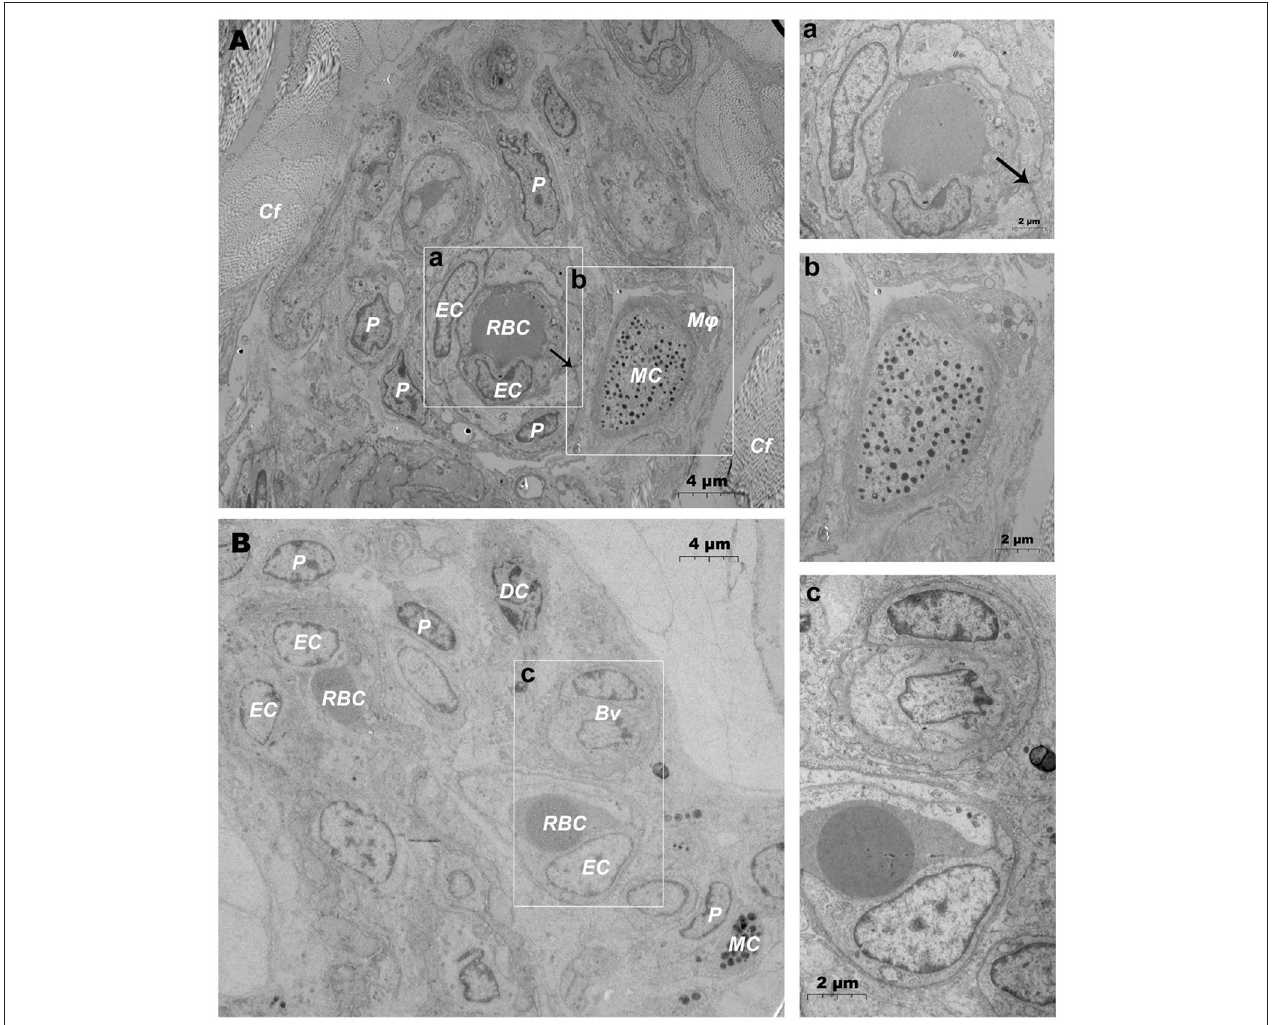
FIGURE 3 | Ultrastructural analysis of microvessels at the steady state via TEM. (A,B) Ultrastructure of microvessels and surrounding cells in steady state; (a) is the magnification of the microvessel in (A) ; (b) is the magnification of the mast cells in (A) ; (c) is the magnification of microvessels in (B) . RBC, red blood cell; EC, endothelial cell; P, pericyte; MC, mast cell; M φ , macrophage; Cf, collagen fiber; Bv, blood vessel; DC, dendritic cell; → , Tight junctions between the pericyte and the endothelial cell. Scale bar (A,B) = 4 µ m; (a–c) = 2 µ